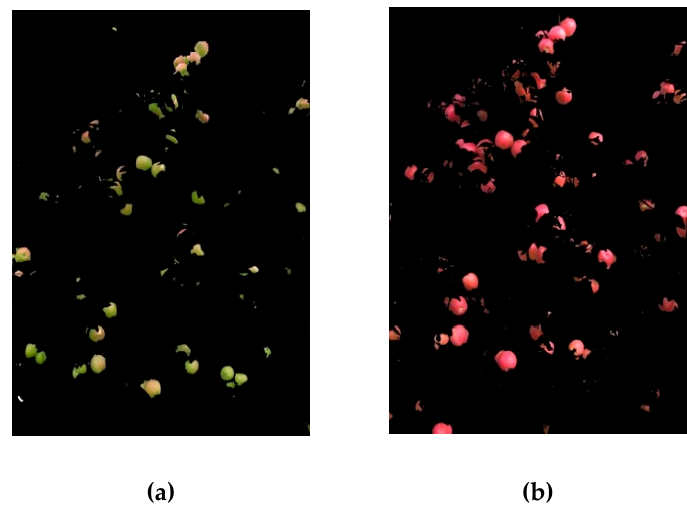
Figure 3. Image of same tree at different times, ( a ) in July; ( b ) in the beginning of September.